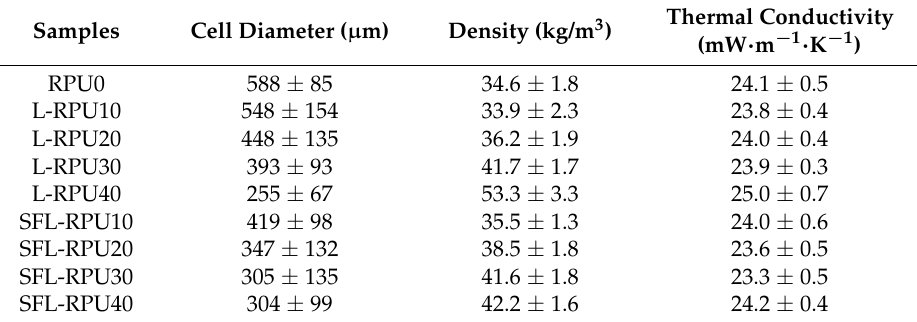
Table 3. Cell diameter, density, and thermal conductivity of RPU foams containing 0–40% lignin.